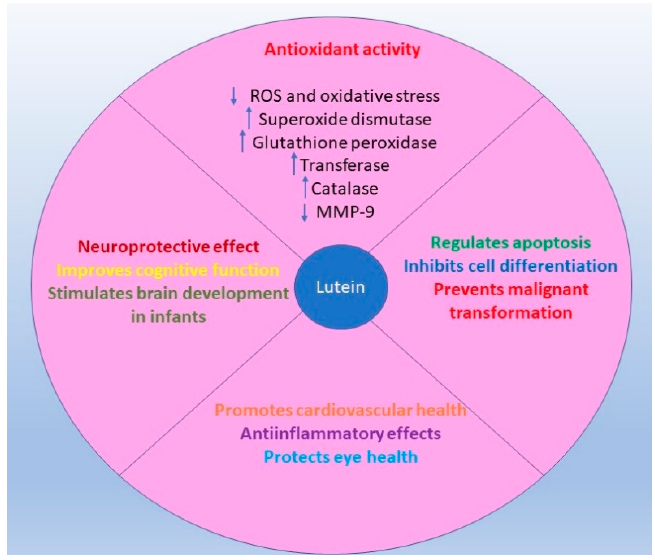
Figure 1. Schematic representation of anti-inflammatory and antioxidant effects of lutein.